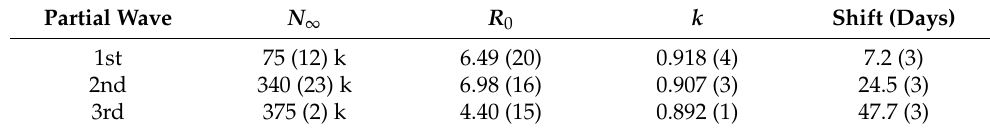
Figure 2. The epicurve of the δ surge of COVID-19 spread in Japan from June to September 2021. ( a ) The logarithmic plot of the number of daily confirmed cases (one week average) and the fit result (solid curve). The fit was performed with three partial waves and a baseline denoted by dashed lines. ( b ) The observed data and fit result of the K-value. Table 3. The parameters of the Gompertz curves in the δ surge in Japan. The N ∞ , R 0 and k are the cumulative number of infected people, basic reproduction number and connected probability of transmission links, respectively. The “shift” stands for the onset of a partial wave from the reference date (25 June 2021). The statistical errors evaluated by the jackknife method are represented in the parentheses.